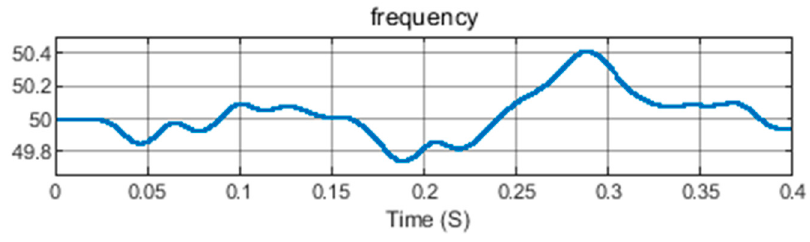
Figure 20. Dynamics response of the system frequency.